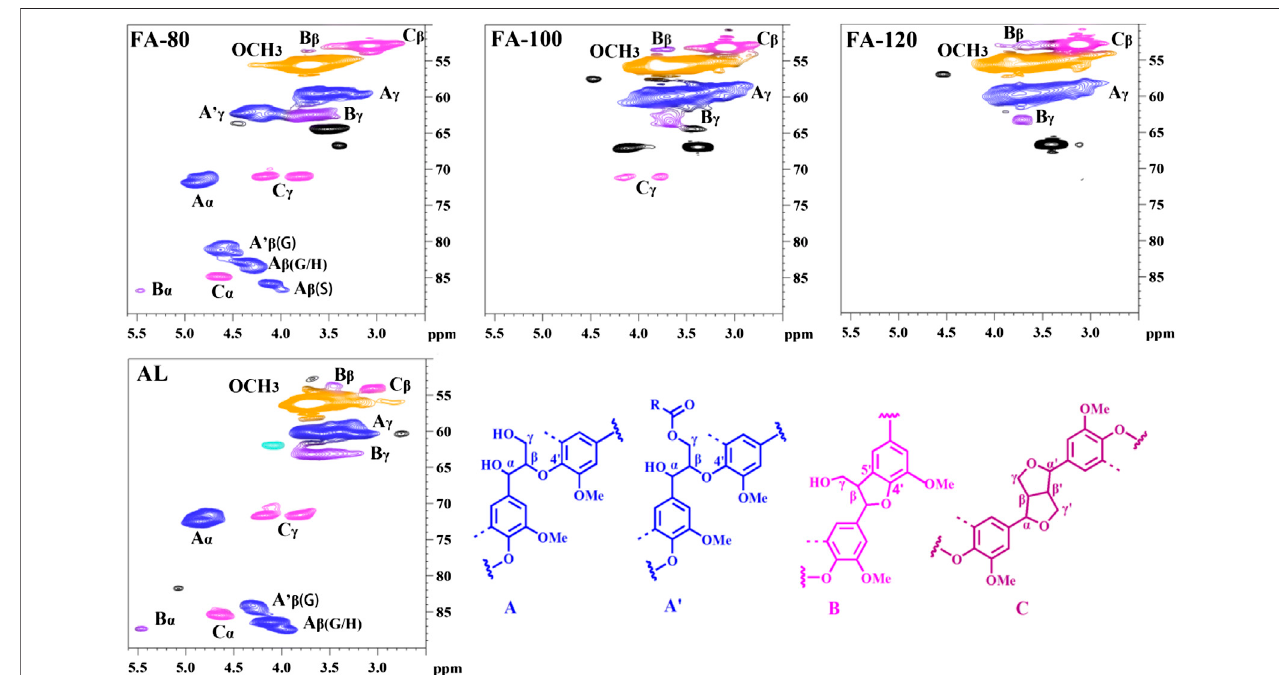
FIGURE 1 | Side-chain regions in the 2D-HSQC spectra of lignin